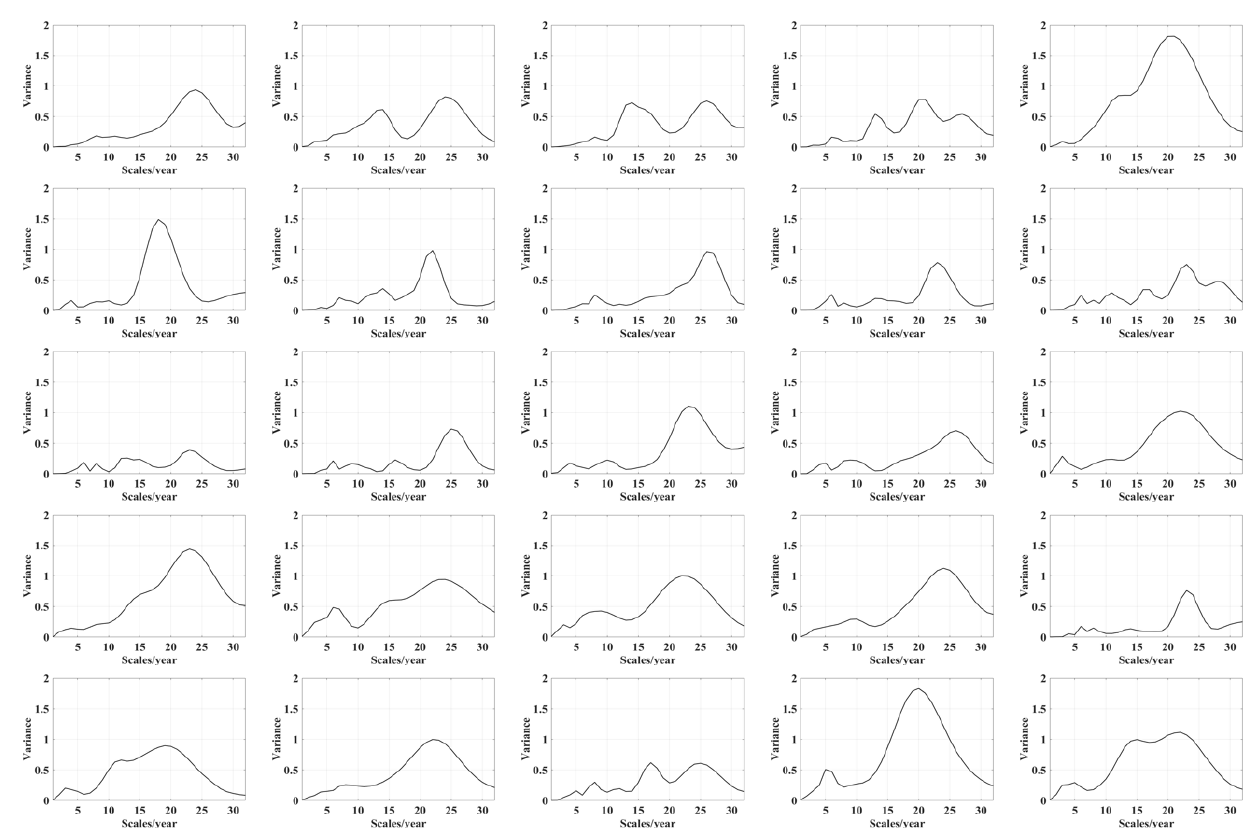
Figure 5. Wavelet variance of annual evaporation variation at 25 stations in the Yangtze River Basin.